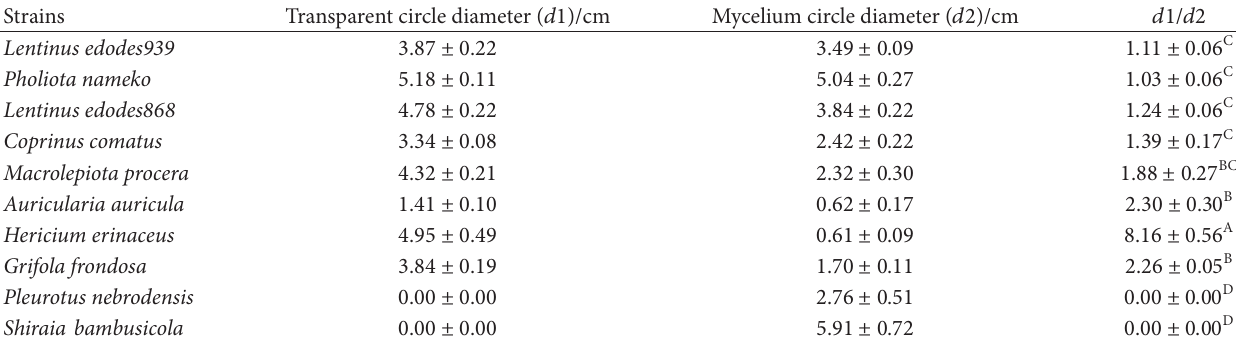
Table 1: Ratio of transparent circle to mycelium circle of 10 strains under CMC